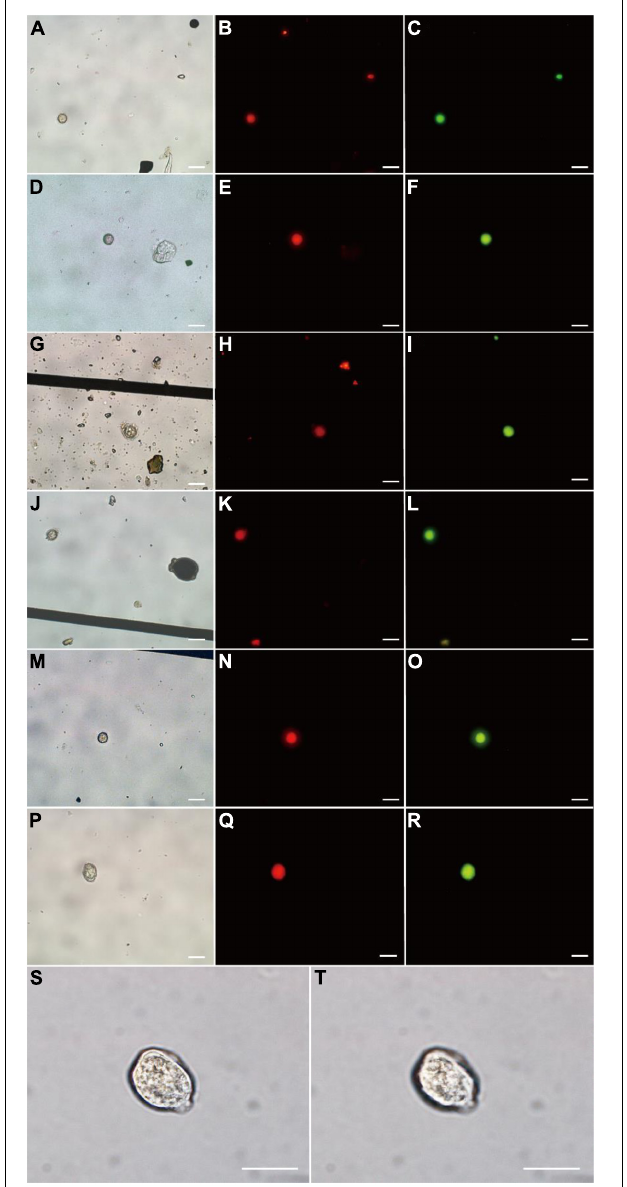
FIGURE 5 | Microscopic observations of Prorocentrum donghaiense resting cysts labeled with two fluorescence signal probes simultaneously (Cy3 and FITC) in sediment. Each cyst was observed at bright field LM (A,D,G,J,M,P) , orange epifluorescent LM for Cy3-labeled cysts (B,E,H,K,N,Q) and green epifluorescent LM for FITC-labeled cyst (C,F,I,L,O,R) , respectively. (S,T) The cyst in (P) observed at 100 × objective lens with different focusing distances. Scale bars = 20 µ m.